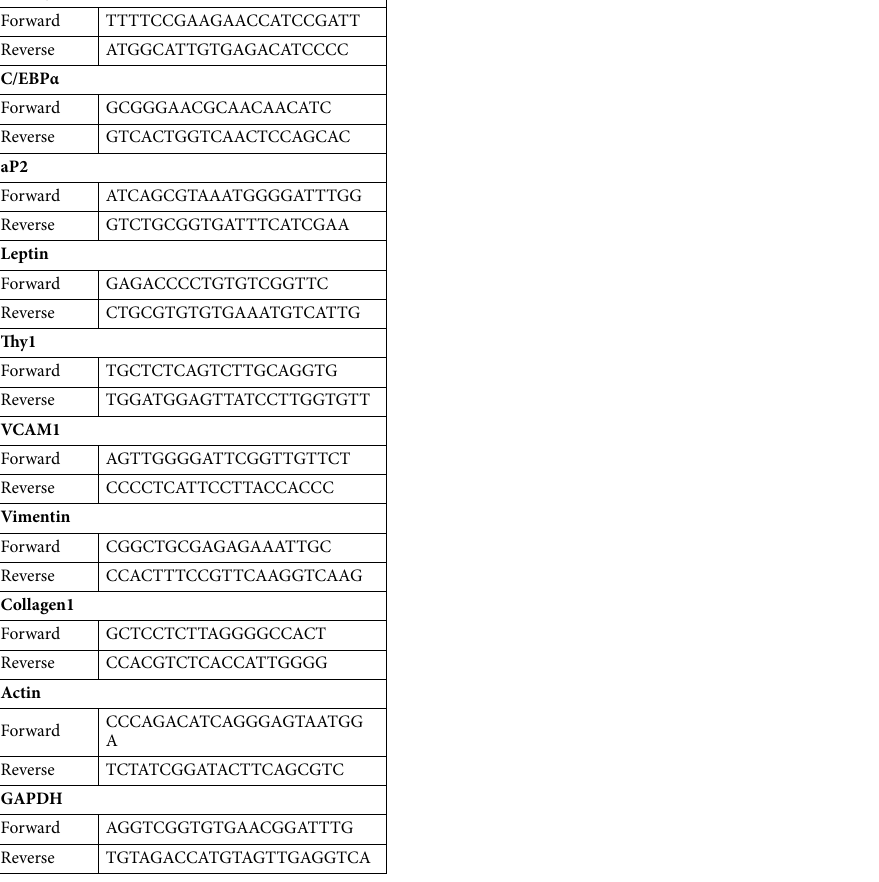
Table 1. Primers for quantitative real-time